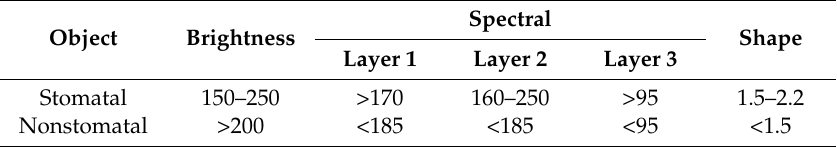
Table 3. Classification object feature threshold range.